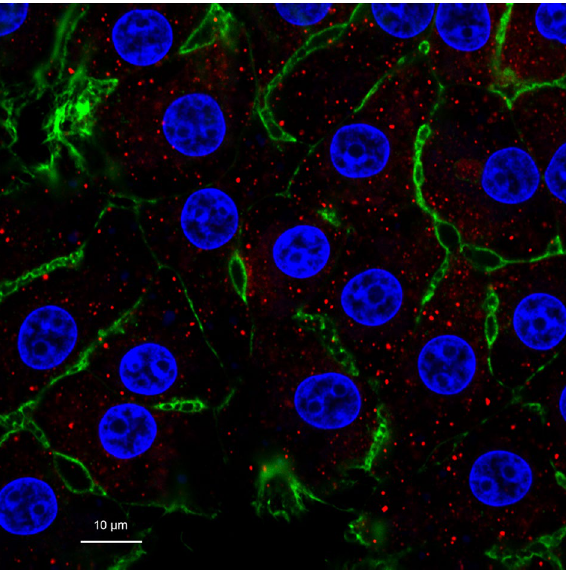
Figure 1. Primary bovine hepatocytes stained with DAPI (nuclei; blue), Alexa Fluor 488 Phalloidin (F-actin; green), and Cy3 for patatin-like phospholipase domain-containing protein 3 (PNPLA3; red). A common trait in hepatocytes, some hepatocytes display binucleated nuclei and some do not. The cytoskeletal protein F-actin outlines the shape of the cells. Appearance of PNPLA3 in red shows it scattered throughout the cytoplasm of the cells, where lipolytic activity occurs.